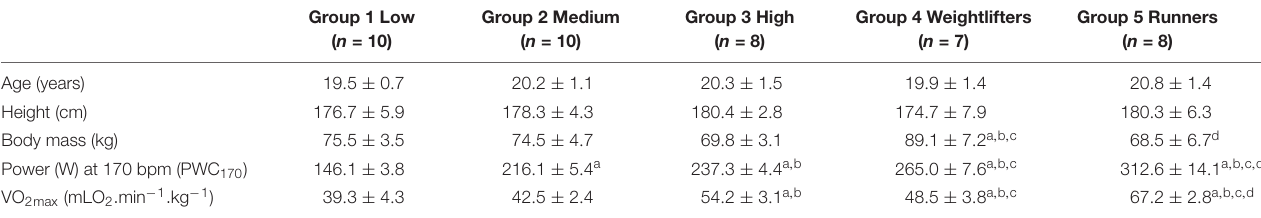
TABLE 1 | Group characteristics.